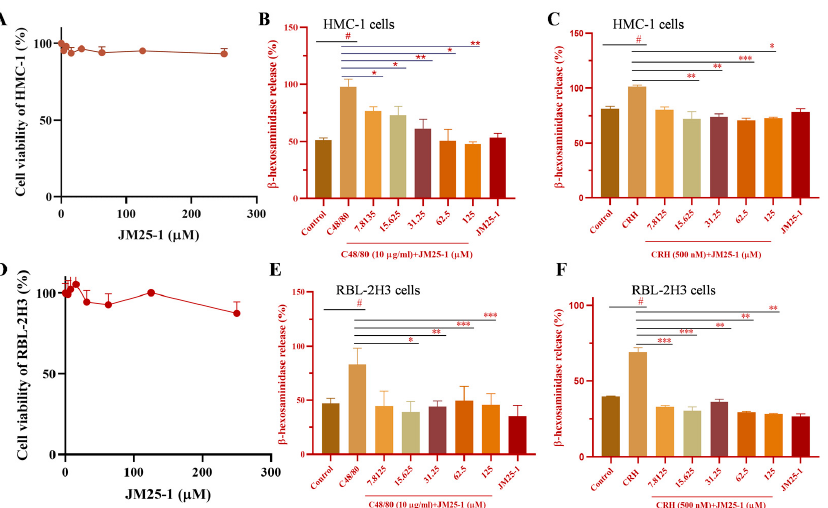
Figure 1. JM25-1 inhibits MC degranulation at safe concentration. ( A ) HMC-1 cells were treated with JM25-1 (0, 3.9, 7.8125, 15.625, 31.25, 62.5, 125, 250 µ M) for 24 h and the cell viability was detected by CCK-8 assay. HMC-1 were pretreated with JM25-1 for 10 min ( B ) in C48/80 or ( C ) CRH-induced degranulation for 15 min. ( D ) RBL-2H3 cells were treated with JM25-1 (0, 3.9, 7.8125, 15.625, 31.25, 62.5, 125, 250 µ M) for 24 h and the cell viability was detected by CCK-8 assay. RBL-2H3 were pretreated with JM25-1 for 10 min ( E ) in C48/80 or ( F ) CRH-induced degranulation for 15 min. The data are presented from at least three independent experiments run in triplicate. Bars, S.D. # p ≤ 0.05 vs. the Control; * p ≤ 0.05, ** p ≤ 0.01, *** p ≤ 0.001 vs. the C48/80 or CRH